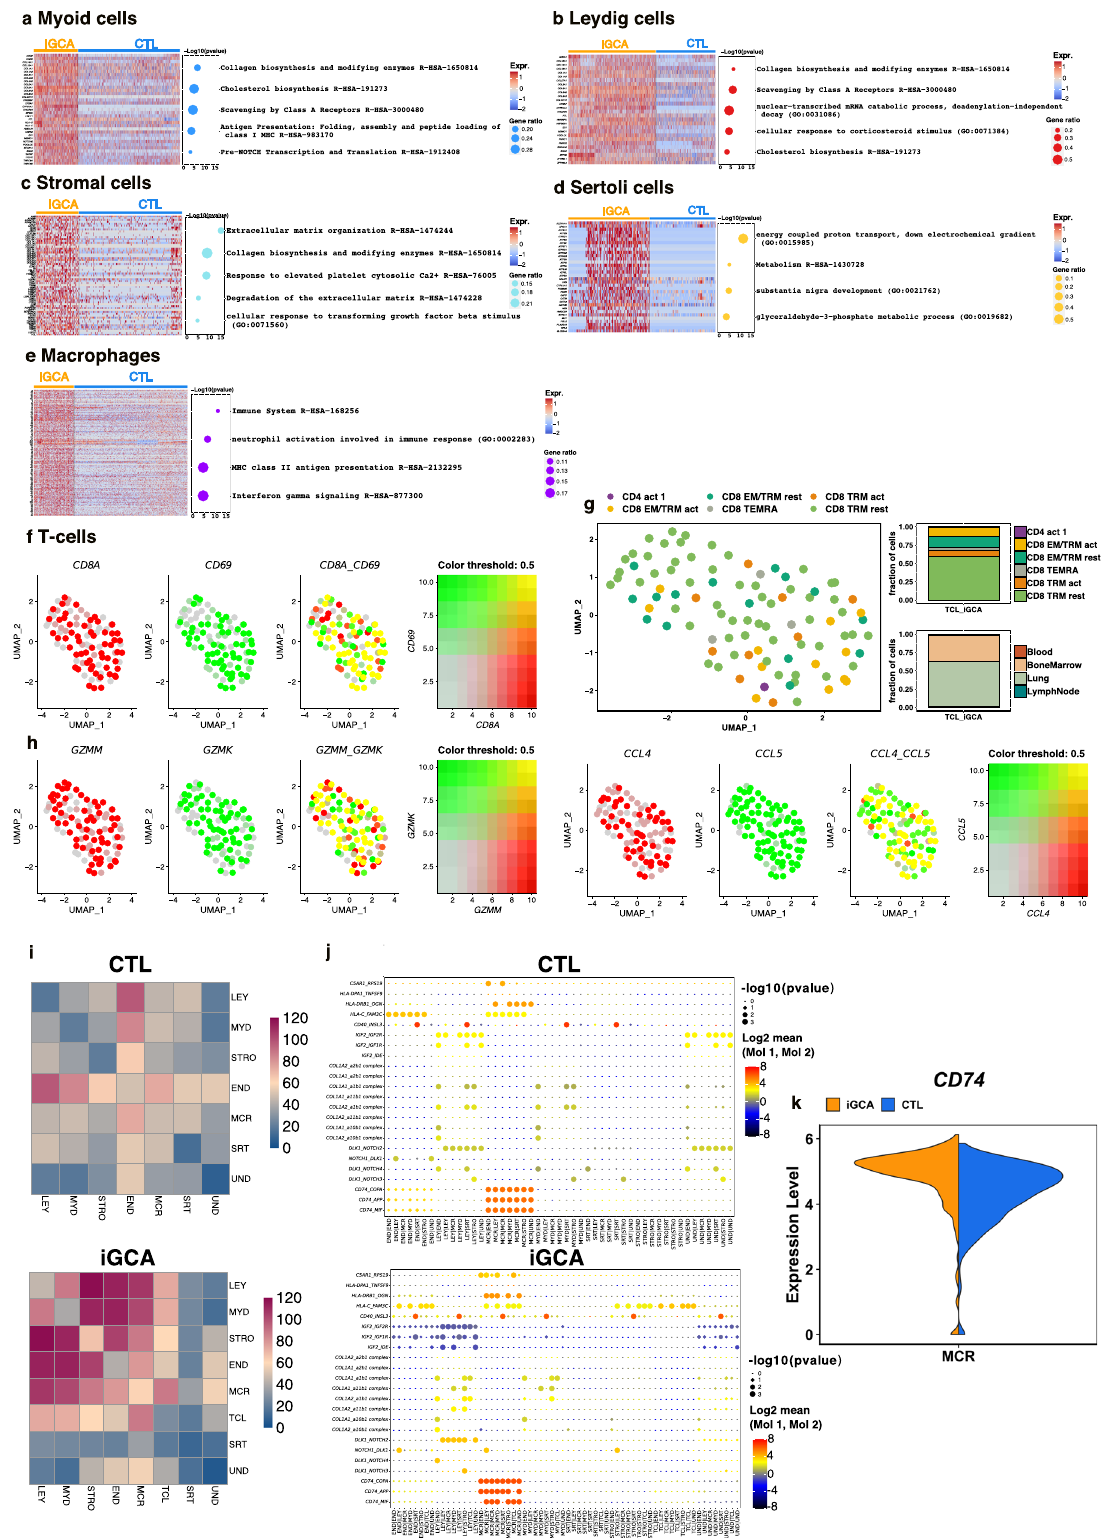
directly responsible for the testicular size and sperm production 37,38 and for steroidogenic activity 39 , respectively. We found that IGF1 was expressed in LEY and MYD cells, and IGF2 down-modulated in LEY, MYD, and SRT cells in iGCA (Fig. 4b; Supplementary information Fig. S8), while no modulation of the relative receptors IGF1R and IGFR2 was